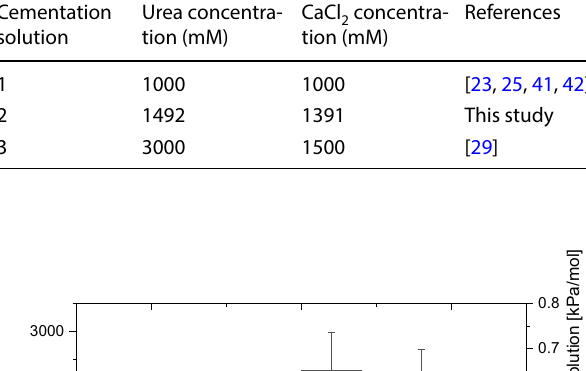
Table 7 Overview of cementation solutions from this study in com- parison to chosen references Cementation solution